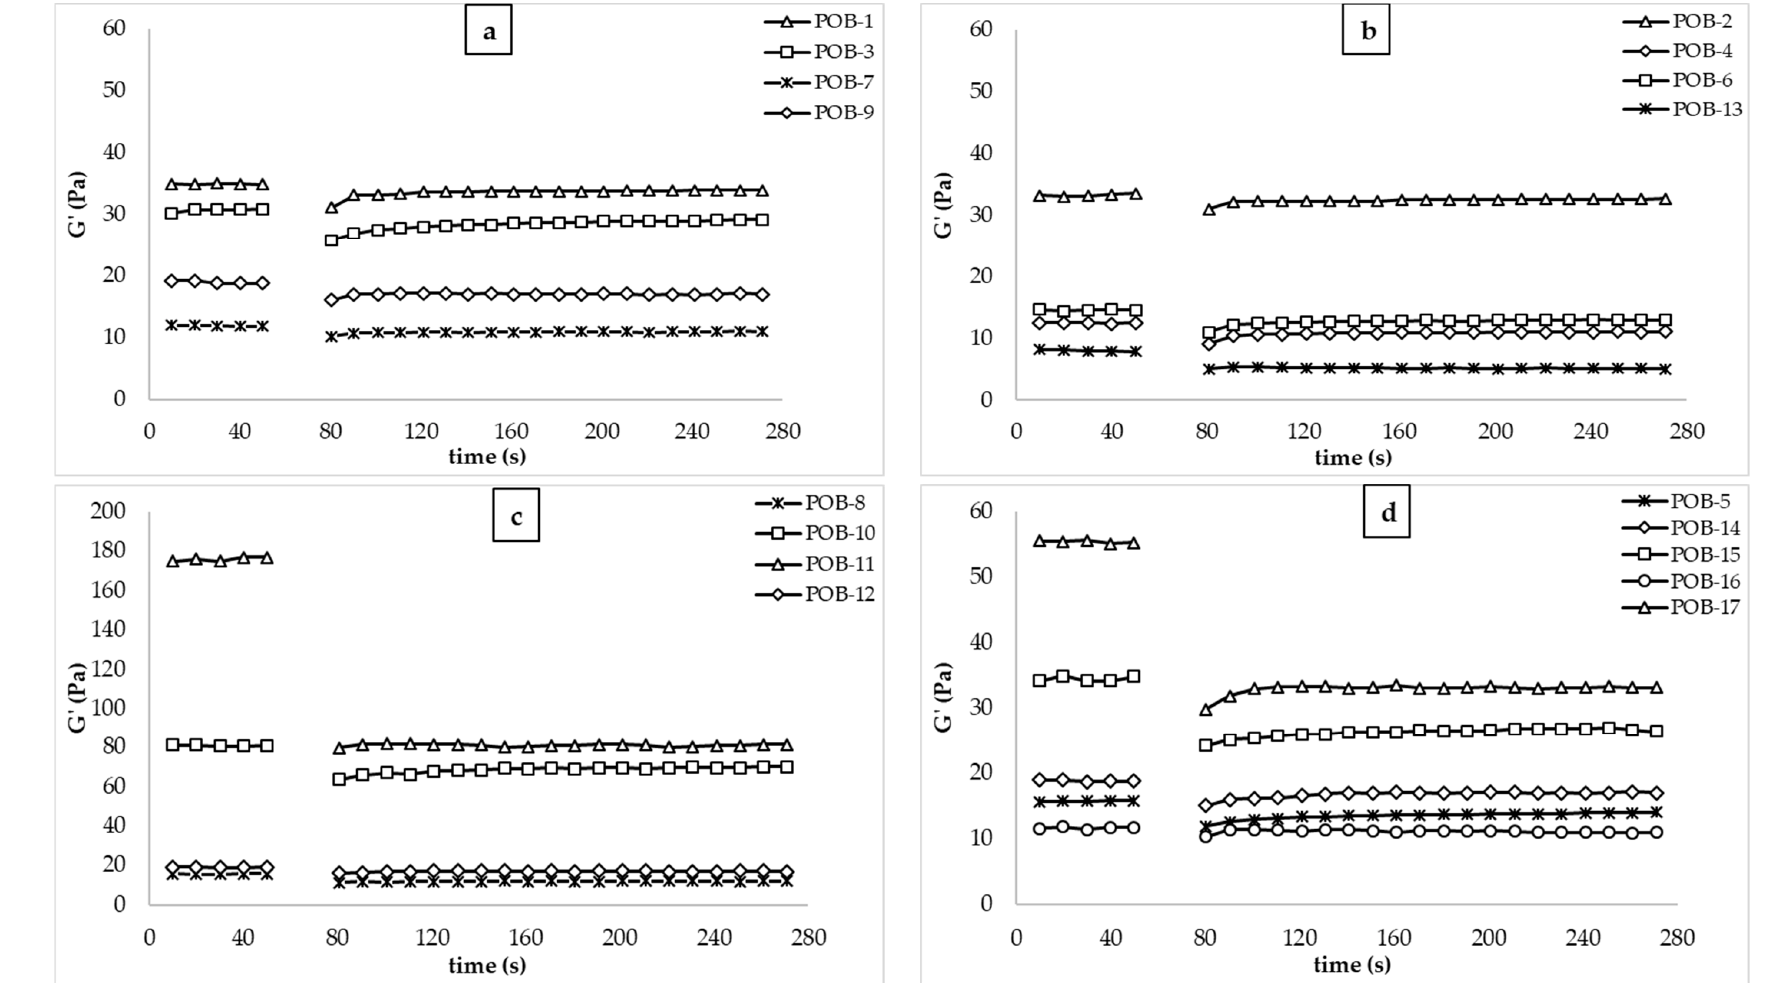
Figure 3. 3-ITT rheological properties of salad dressing samples (POB: cold-pressed pumpkin seed oil by-product, G ′ (Pa): storage modulus)). ( a ): G ′ of POB-1, 3, 7, & 9; ( b ): G ′ of POB-2, 4, 6, & 13; ( c ): G ′ of POB-8, 10, 11, & 12; ( d ): G ′ of POB-5, 14, 16, & 17.